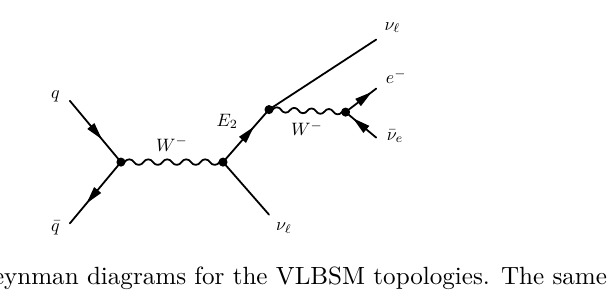
Figure 3. Leading-order Feynman diagram for the ZA topologies. The same nomenclature as in figure 2 applies here.